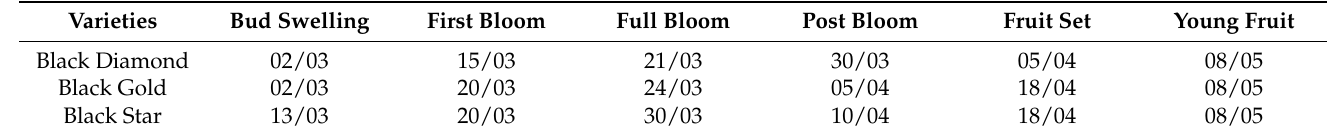
Table 1. Phenological stages of three plum cultivars grown in the Regueb